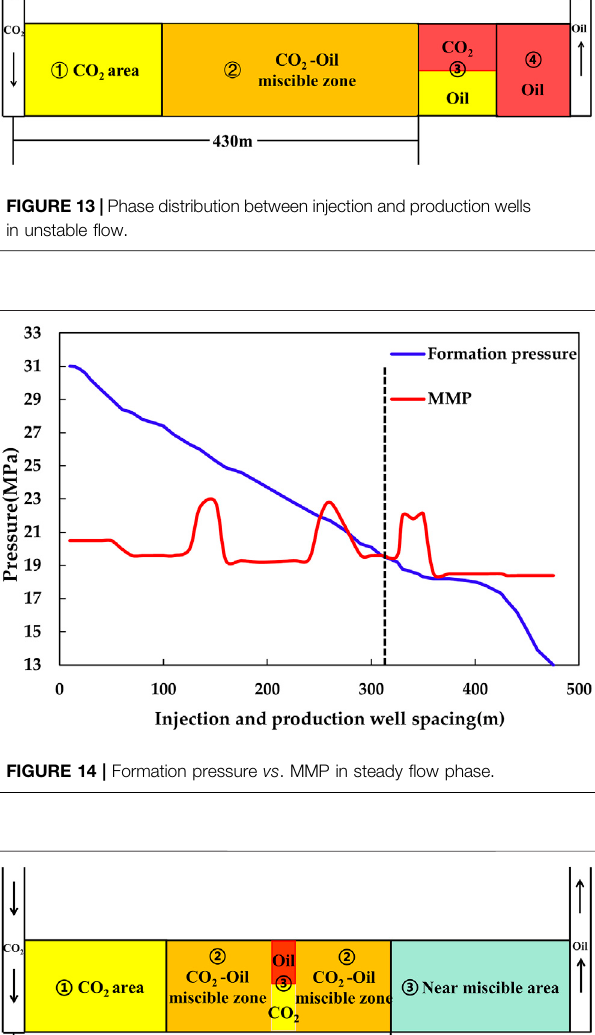
Frontiers in Energy Research |